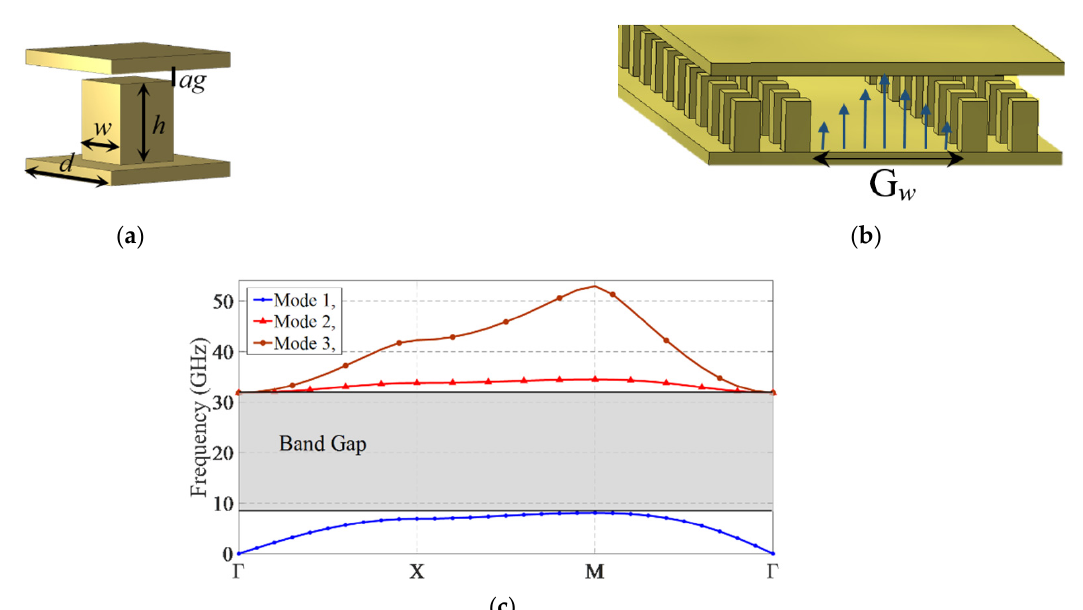
Figure 1. ( a ) Periodic pin structure, ( b ) groove gap waveguide structure, and ( c ) the dispersion diagram of the pins. The parameters are h = 4.5 mm, w = 1.65 mm, d = 4.1 mm, ag = 0.1 mm, and G w = 15.8 mm.